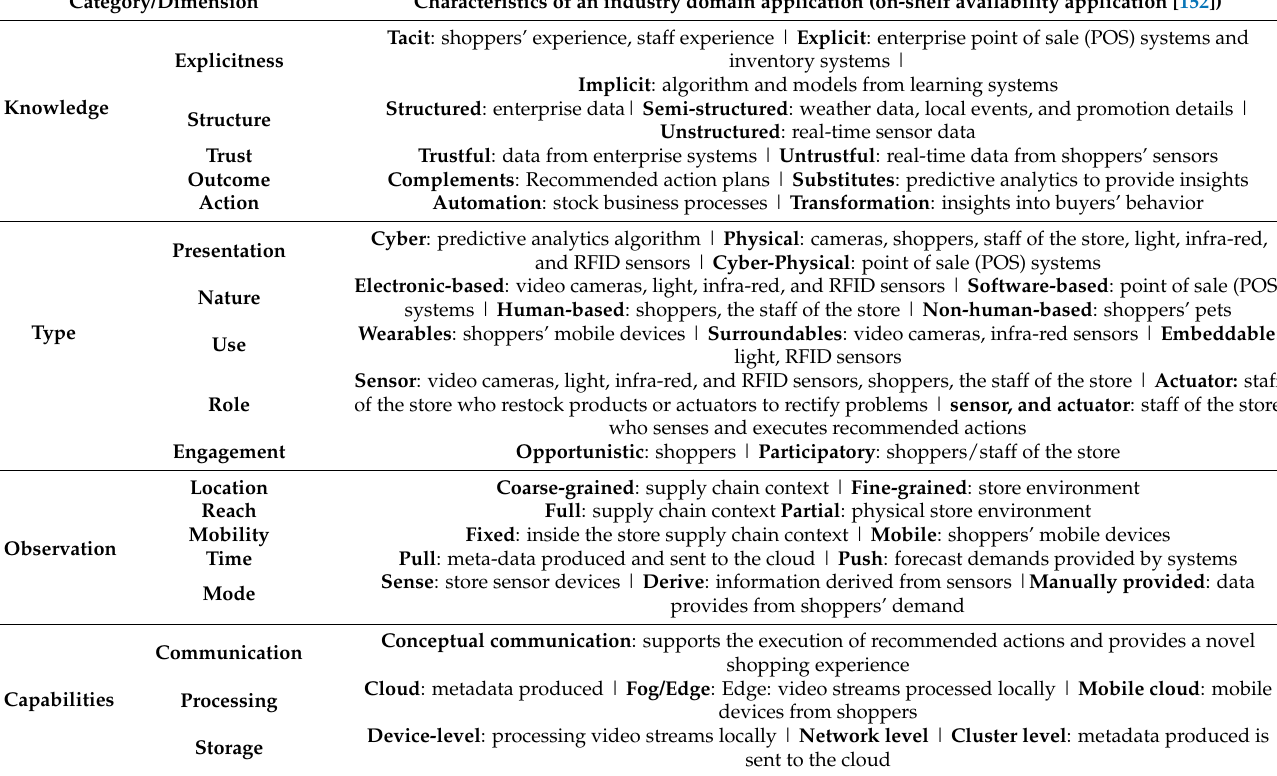
Table 4. Classification of IoE enablers of a specific industry domain application [114], according to IoE proposed taxonomy